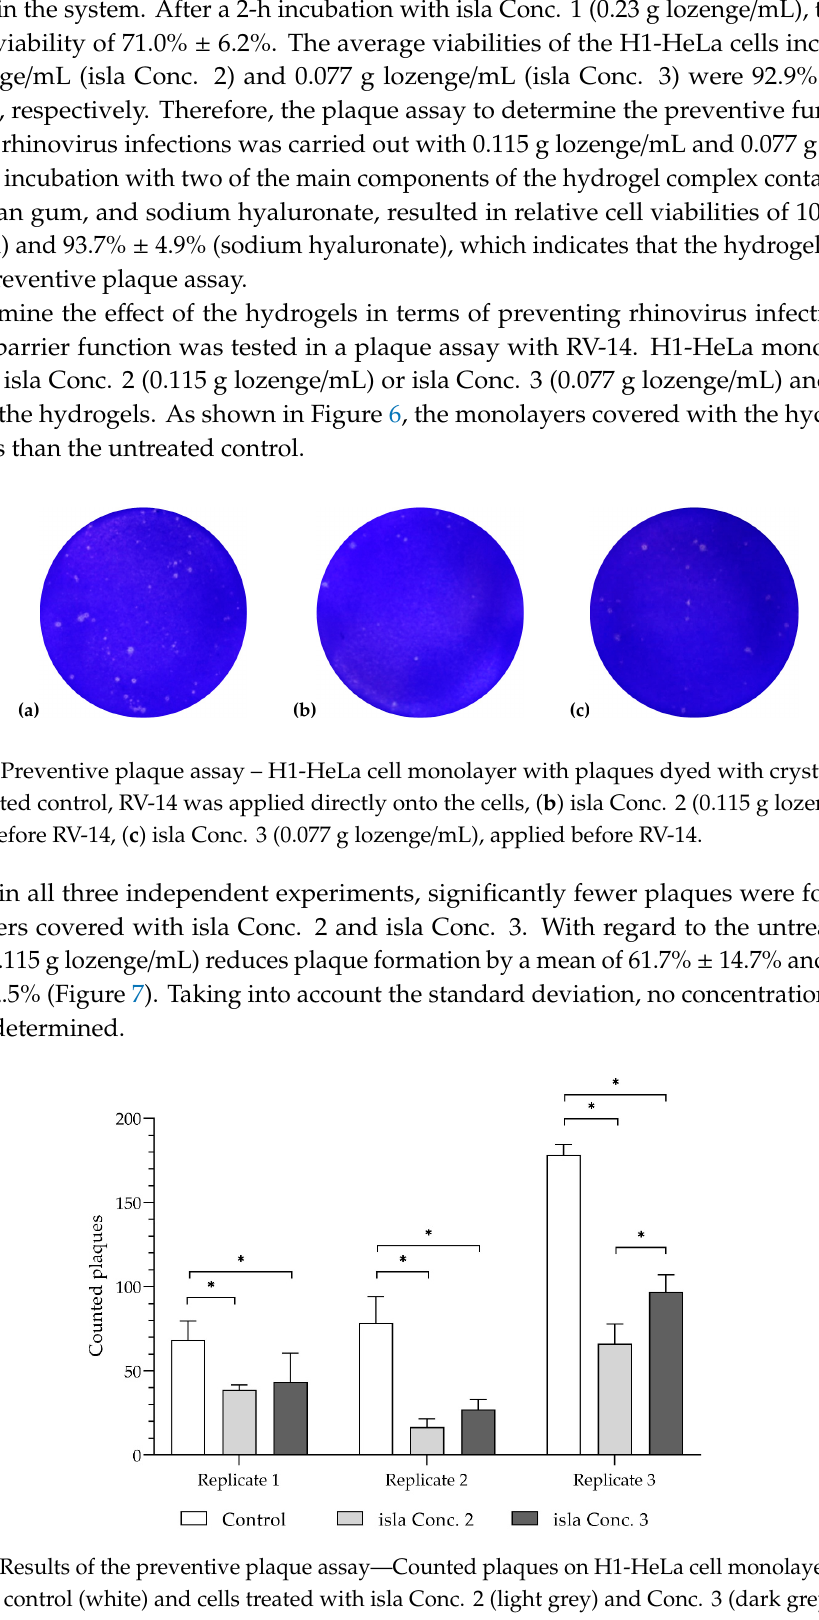
Figure 8. Results of the preventive plaque assa—Counted plaques on H1-HeLa cell monolayers of the untreated control (white) and cells treated with 0.35% xanthan gum (light grey) or 0.65% sodium hyaluronate (dark grey), mean ± standard deviation of the independent test runs with two repetitions, * p ≤ 0.05.